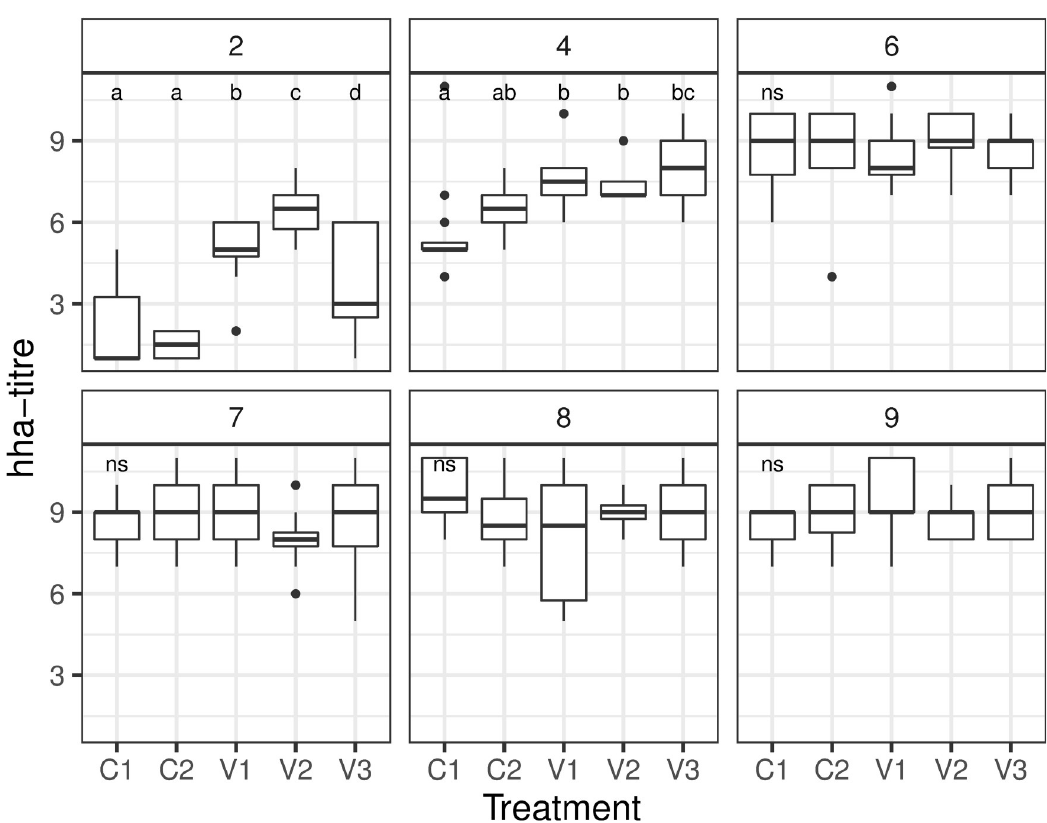
Fig 4. Boxplot presenting the results of the HHA test over the nine weeks of the study. Small letters indicate significant differences between groups within weeks with 2,4,6,7,8,9 indicating the age of the chickens in weeks.